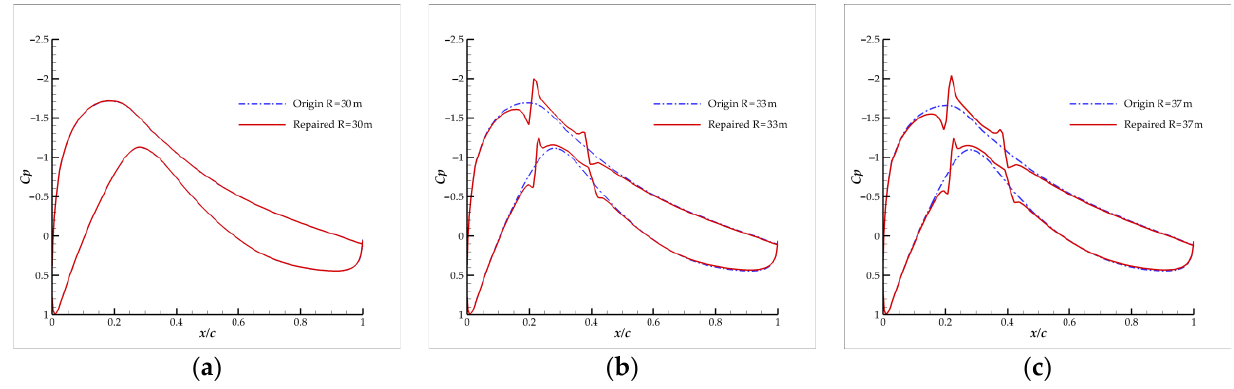
Figure 23. Aerodynamic pressure coefficient distribution in 2D repair profile of 3D repaired blade: ( a ) R = 30 m; ( b ) R = 33 m; ( c ) R = 37 m.